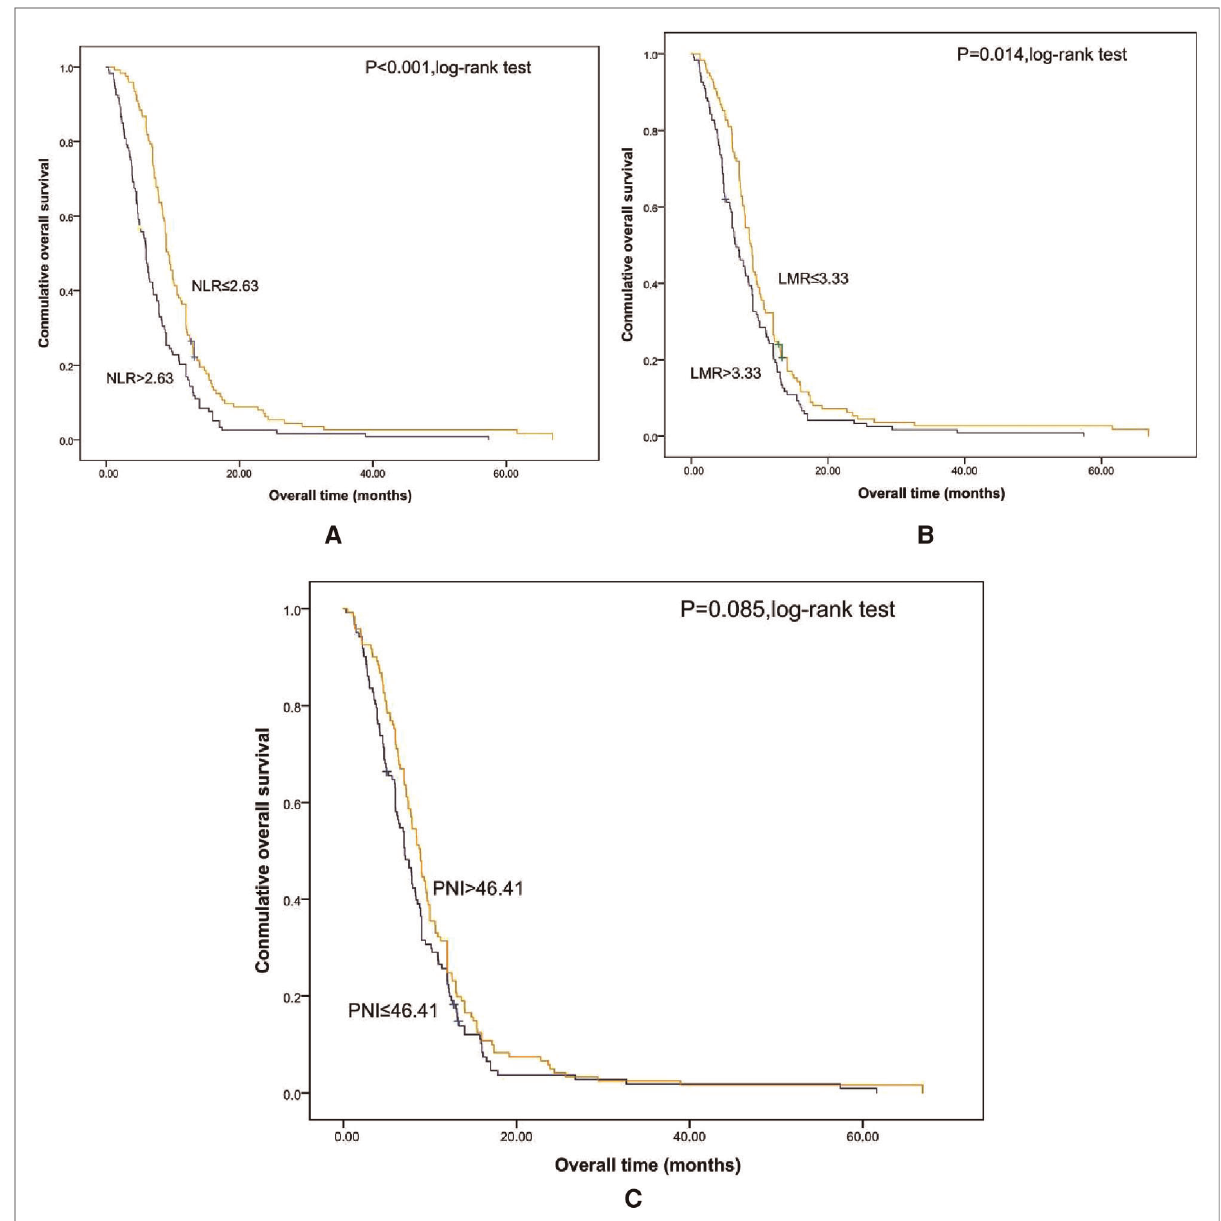
FIGURE 3 Kaplan-Meier graphs of OS for patients with NLR ( A ), LMR ( B ), and PNI ( C ). OS, overall survival; NLR, neutrophil/lymphocyte count; LMR, lymphocyte/ monocyte; PNI, albumin (g/L)+5×lymphocyte count (10 9 /L).